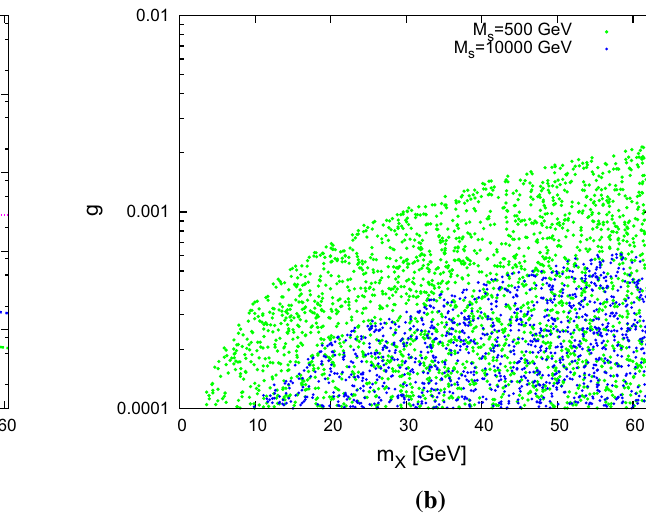
g for different values of M s , which are consistent with the experimental measurements of Br ( H 1 → Invisible